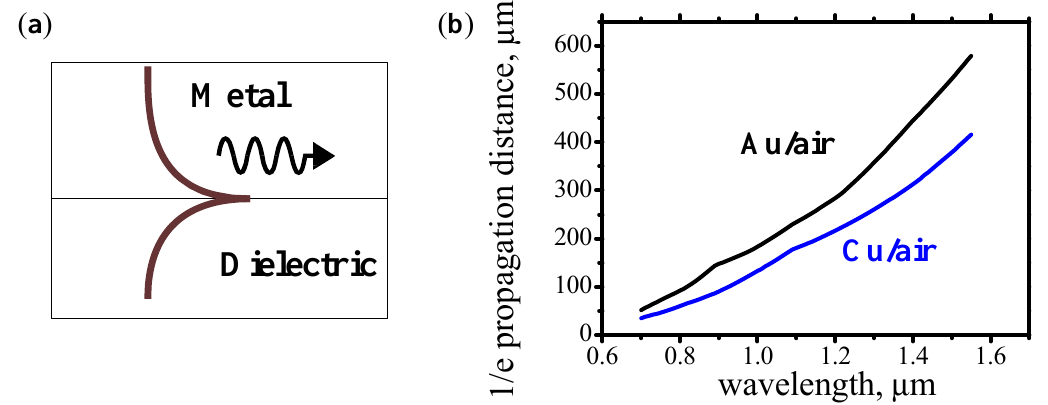
Figure 1. ( a ) Schematic diagram showing the intensity of optical field for a surface plasmon propagating along the metal-dielectric interface. Brown line is intensity distribution across the interface; ( b ) 1/e propagation distance for the surface plasmons propagating along Au/air and Cu/air